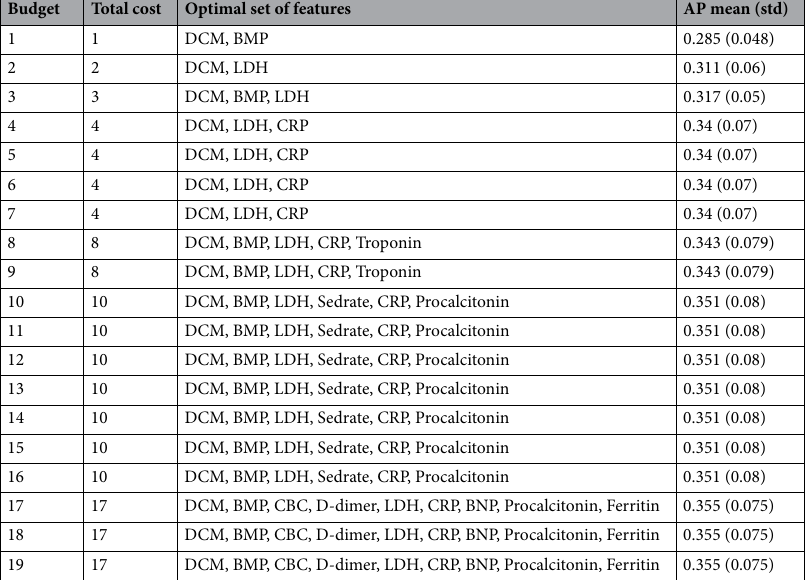
Table 6. Optimal set of features at different budget levels for predicting mortality. Total cost is the sum of the cost of each feature group in the selected set.